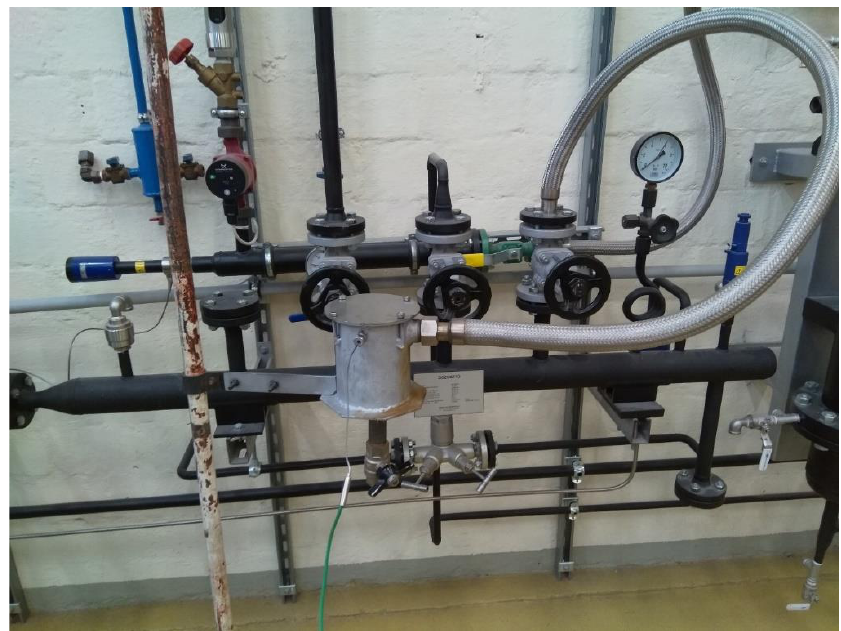
Figure 6. Chamber of pre-foaming.